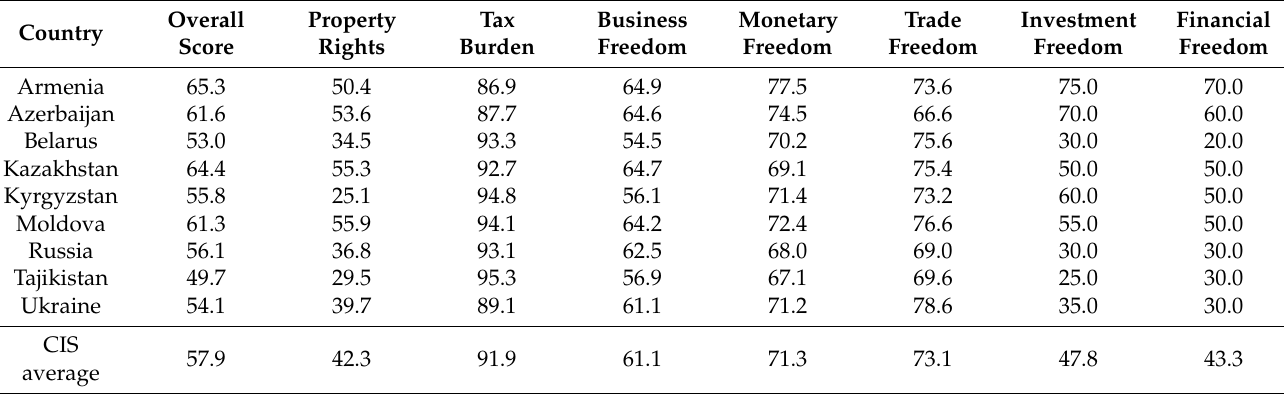
Table 3. Index of Economic Freedom.